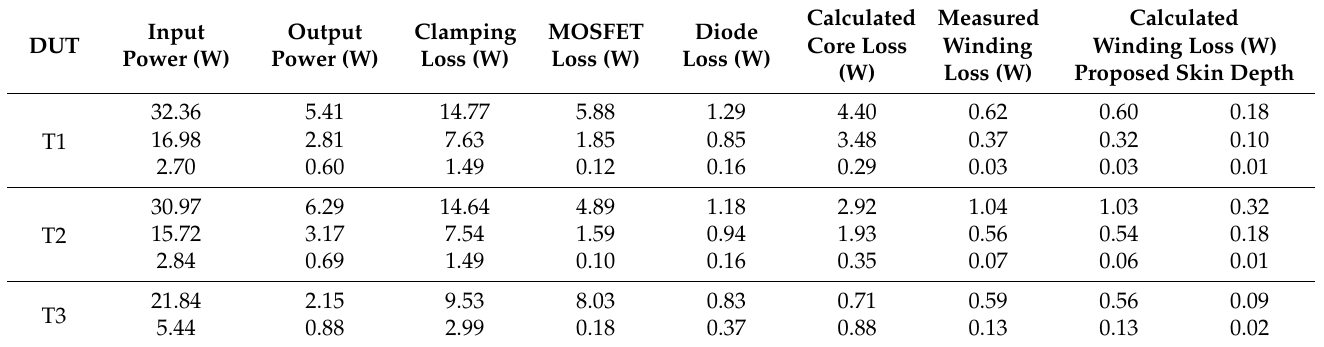
Table 4. Measured values in the flyback converter